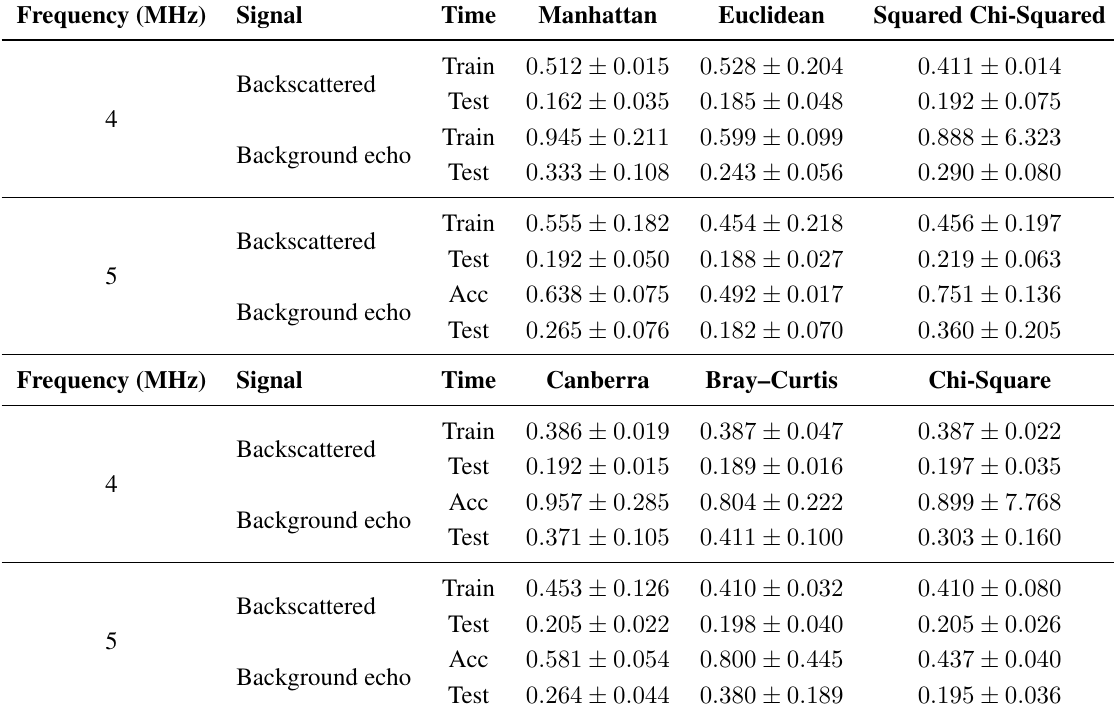
Table 14. Average of training and testing times in milliseconds for the 4- and 5-MHz frequency signals at 650 and 950 ◦